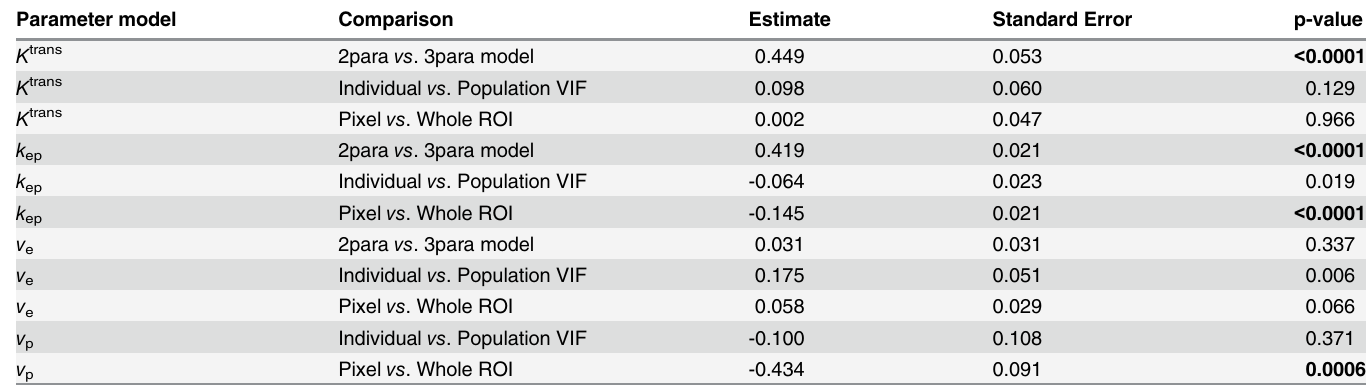
Table 2. Summary of pairwise comparisons between DCE-MRI parameters by analytical method. P-values based on linear mixed model on the loga- rithmic scale. The linear mixed model took into account correlation between measurements from the same rat. A Bonferroni adjustment was used to control the overall type I error rate, which with 13 pairwise comparisons set the cutoff point for declaring statistical significance as 0.05/13 = 0.0038, which are